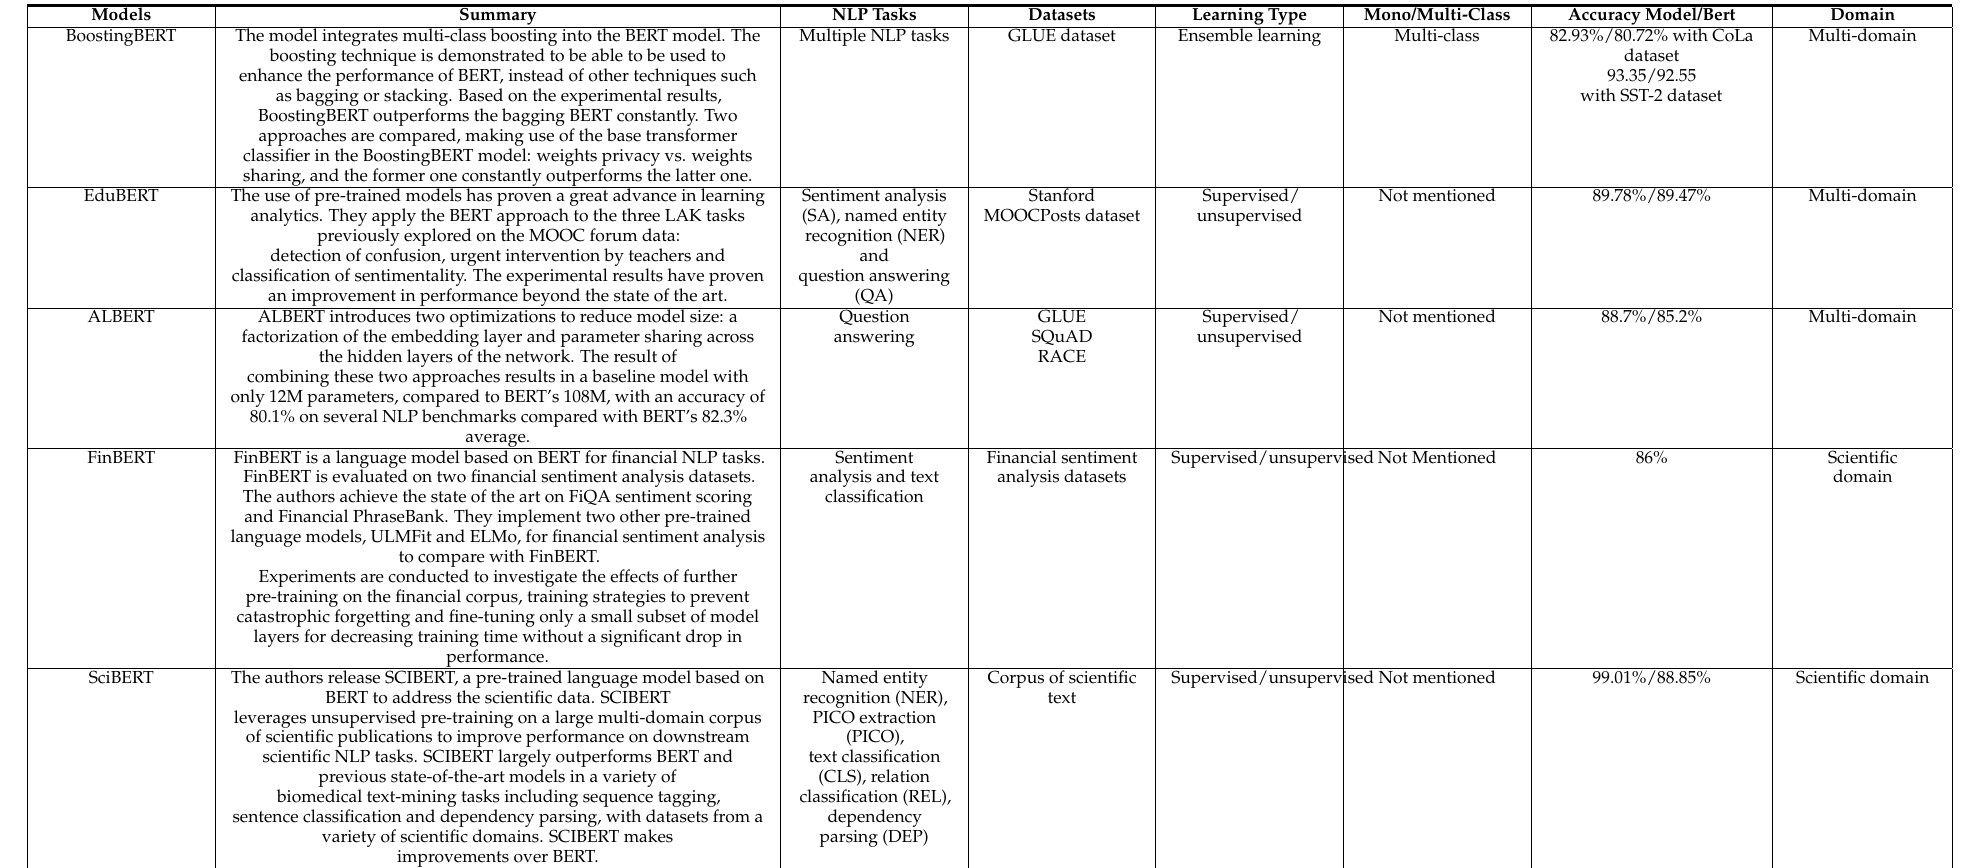
Table 1. A comparative study of pre-trained Bert-base